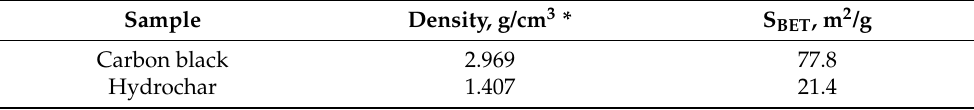
Table 3. Results of S BET determination. Sample Density, g/cm 3